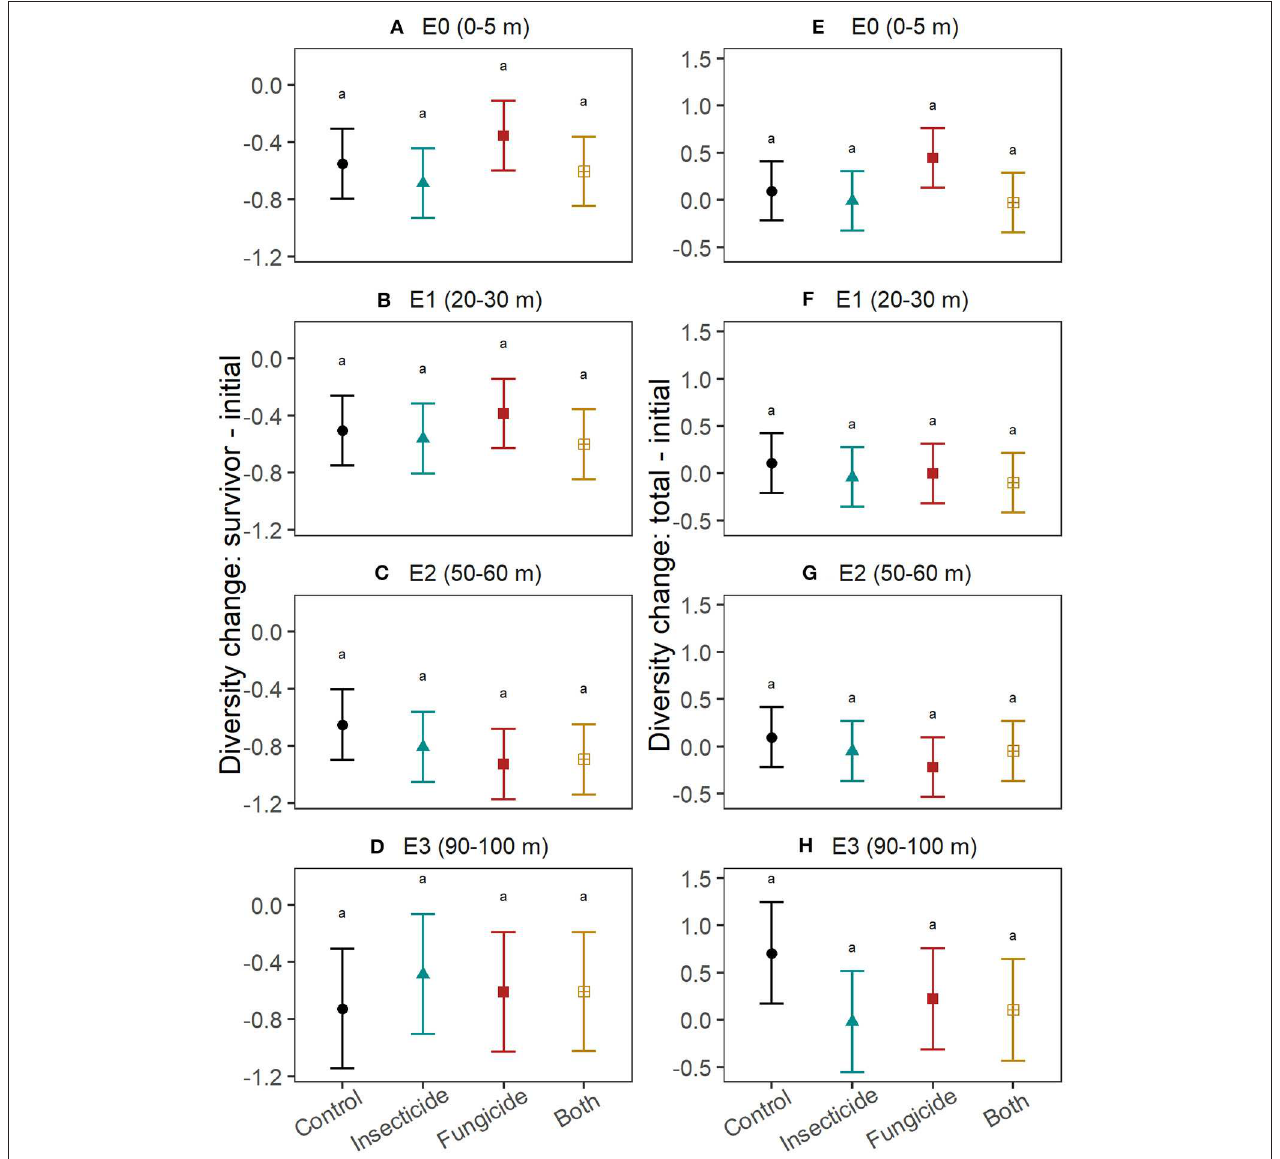
FIGURE 4 | Effects of insects and fungi on change in seedling diversity. Graphs show the effect of suppressing fungi and insects on changes in diversity between seedlings alive in the initial census and those that survived until the end of the study (A–D) and on changes in diversity between seedlings alive in the initial census and all seedlings alive in the final census (survivors + recruits; E–H ), at increasing distances from the forest edge. For each response, patterns were assessed using linear mixed effects models with stations included as a random intercept. Points show the estimated mean response and error bars are the associated 95% confidence intervals. Letters denote significance (at alpha = 0.05) of pairwise comparisons assessed using Tukey’s post-hoc tests, with P-value correction for multiple comparisons. Differences between control and pesticide treatments within each edge-distance for change in total diversity at E3 (90–100m) were significant at alpha =